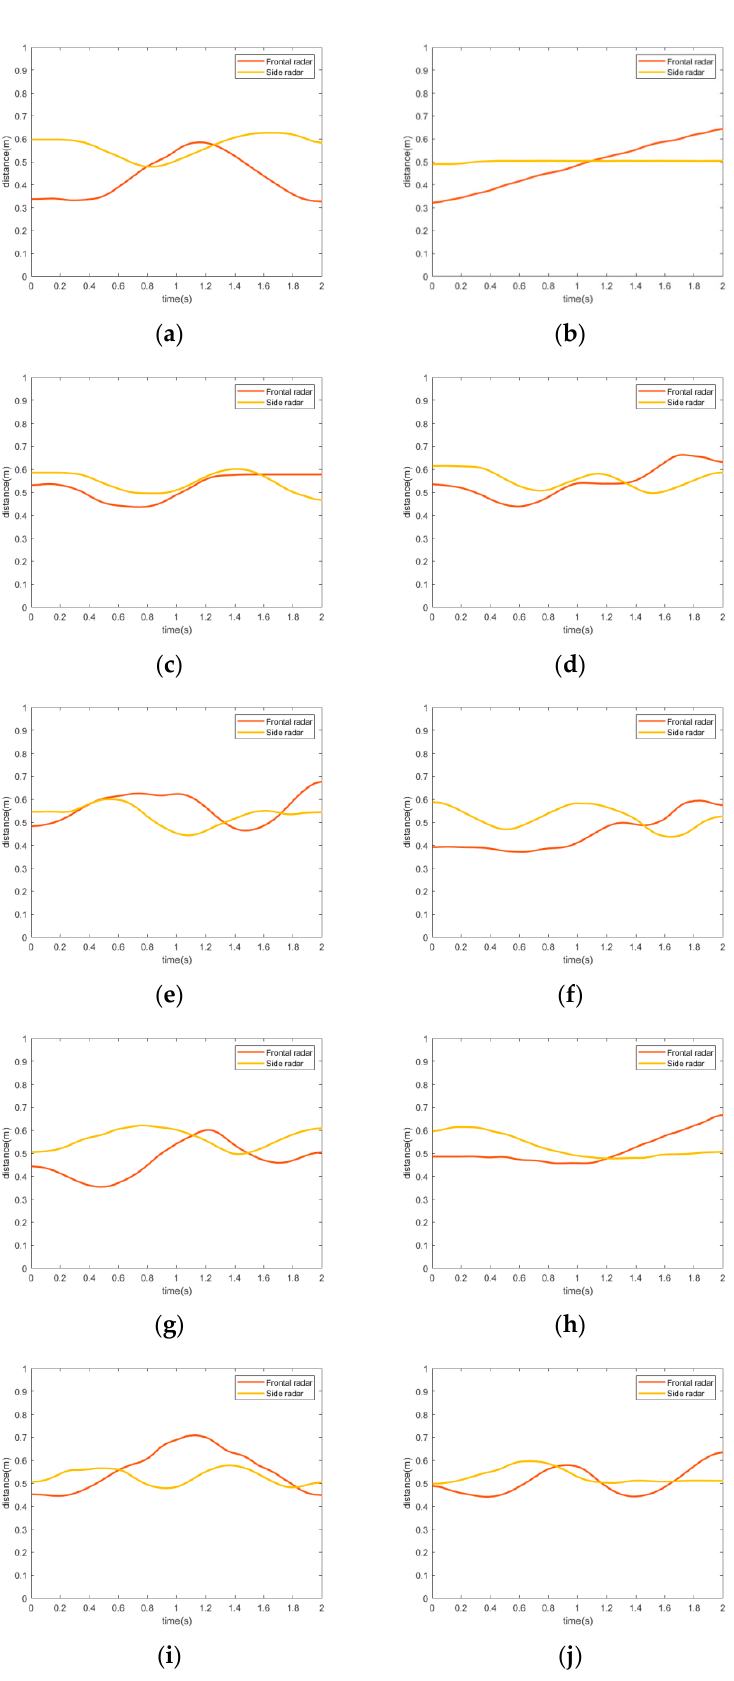
Figure 6. The frontal- and side- trajectories of air writing digits: ( a ) 0; ( b ) 1; ( c ) 2; ( d ) 3; ( e ) 4; ( f ) 5; ( g ) 6; ( h ) 7; ( i ) 8; ( j )